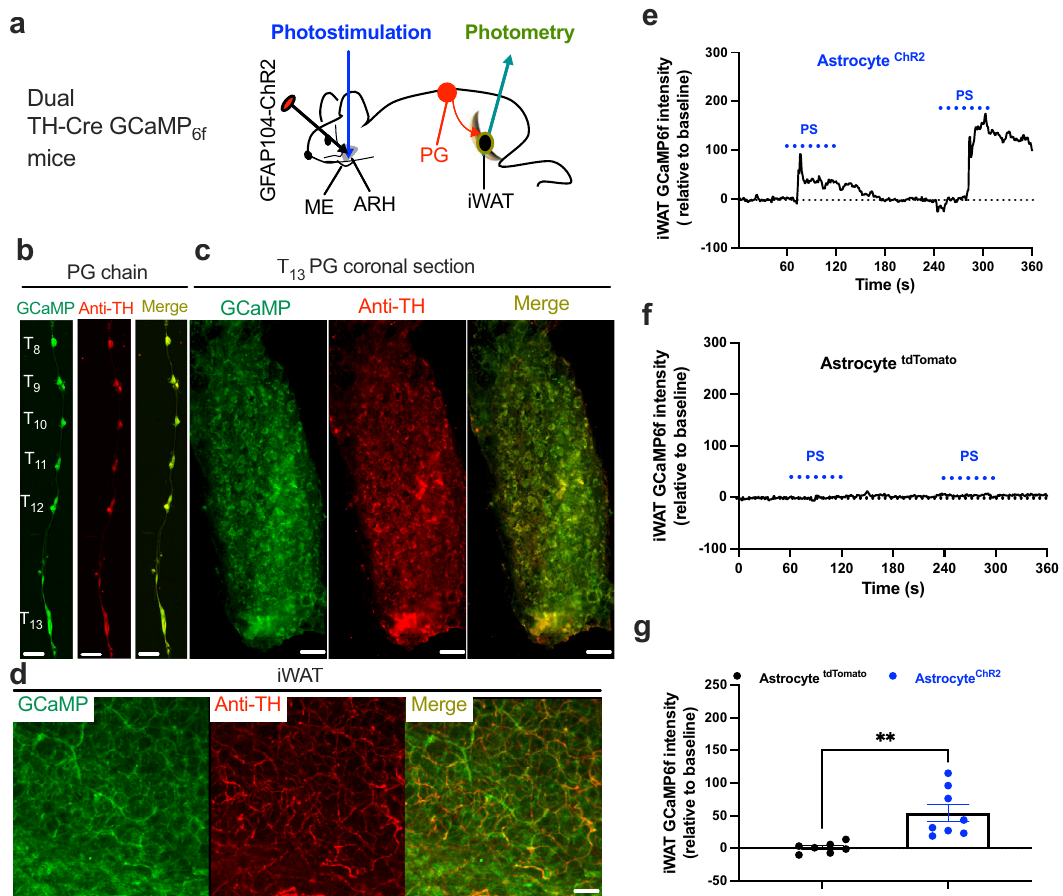
d inguinal iWAT. e - g PS of astrocytes excited sympathetic neural inputs in the inguinal iWAT: Representative traces of photometry monitoring of iWAT GCaMP 6f signalswithPSofastrocytesinthe e ChR2-and f tdTomato-transduceddualTH-Cre GCaMP 6f mice; and g Group data of average GCaMP 6f signals (tdTomato, n =7; ChR2, n =8).Two-tailedStudent ’ s t -tests;datarepresentmean±s.e.m.;** p =0.0025 ( t =3.727, df=13)<0.01. Scale bars for b 2mm and c 50 μ m. PG paravertebral ganglia. Blue dotted lines in e and f indicated the PS duration (20Hz for 1s; repe- ated every 4s for